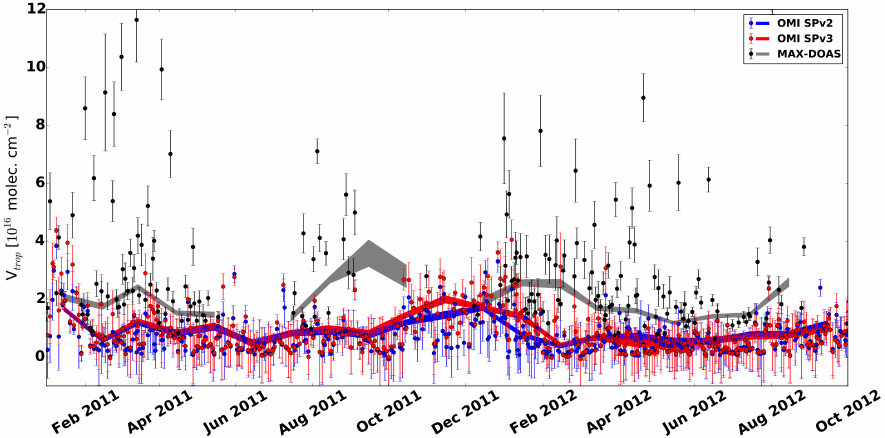
Figure 10. Comparison of OMI data with MAX-DOAS data retrieved in Hong Kong. The OMI daily data have been spatially interpolated and gridded on a 1km × 1km grid, and then the pixel for the measurement site has been extracted. The dots show daily values and the error bars. The lines connect monthly averages; their thickness is proportional to errors in monthly averages. Note that, compared to other parts of eastern China, V trop values do not decrease significantly in SPv3 and even increase for some months, probably because of the improved a priori profiles better capturing the sharp contrast between clean ocean profiles and steep vertical gradients in one of the most densely populated cities in the